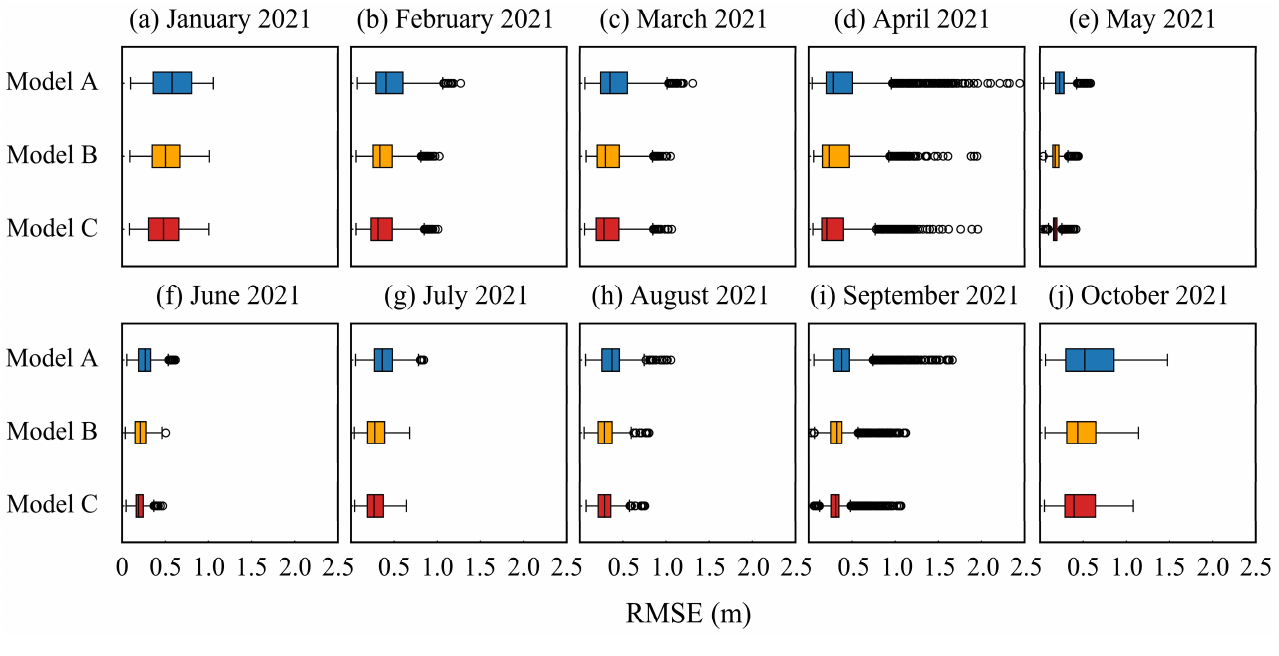
Figure 7. Statistical analysis of monthly mean RMSE of Model A, B, and C at 24-h SWH forecasting results. ( a )-( j ) January to October 2021, respectively.